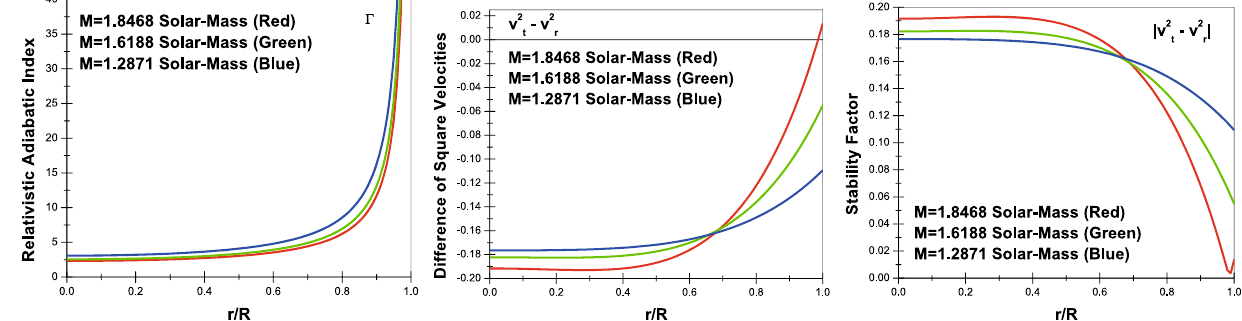
Fig. 5 Figures show the relativistic adiabatic index, (cid:13) , the difference of square velocities, v 2 t − v 2 r , and the stability factor, | v 2 t − v 2 r | , for three different values of the mass M versus the normalized radial coordinate r / R . Left Panel : Relativistic adiabatic index against r / R . Middle Panel : Differenceofsquarevelocitiesagainst r / R . RightPanel :Stabilityfactor